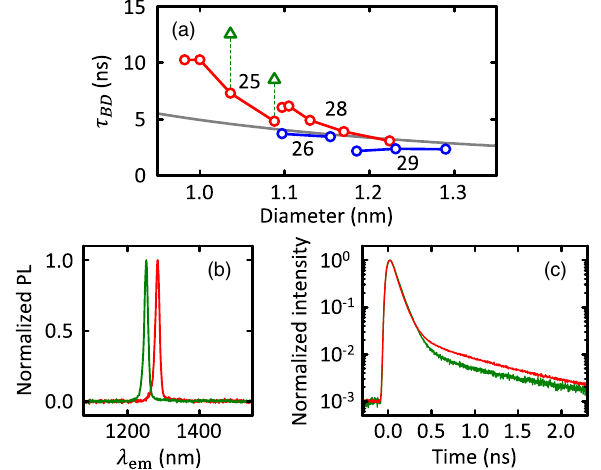
FIG. 4. (a) Diameter dependence of τ . The data are taken BD from tubes with L ≥ 2 . 5 μ m and with P ≤ 5 nW. Chiralities with the same family number are connected, and the family numbers are displayed. Red and blue circles correspond to chiralities which belong to type 1 and type 2, respectively. Gray line is a fit described in the text. Green triangles are obtained from molecular desorbed state of (9,7) and (10,5) CNTs. (b),(c) Normalized PL spectra and PL decay curves, respectively, of the same (9,7) CNT. Red and green lines correspond to molecular adsorbed and desorbed states,